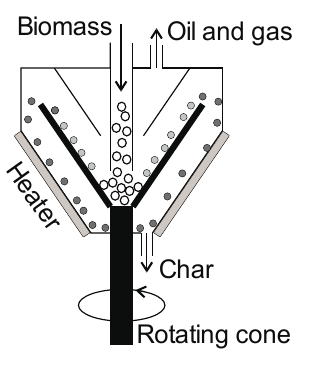
Figure 13. Rotating cone reactor.